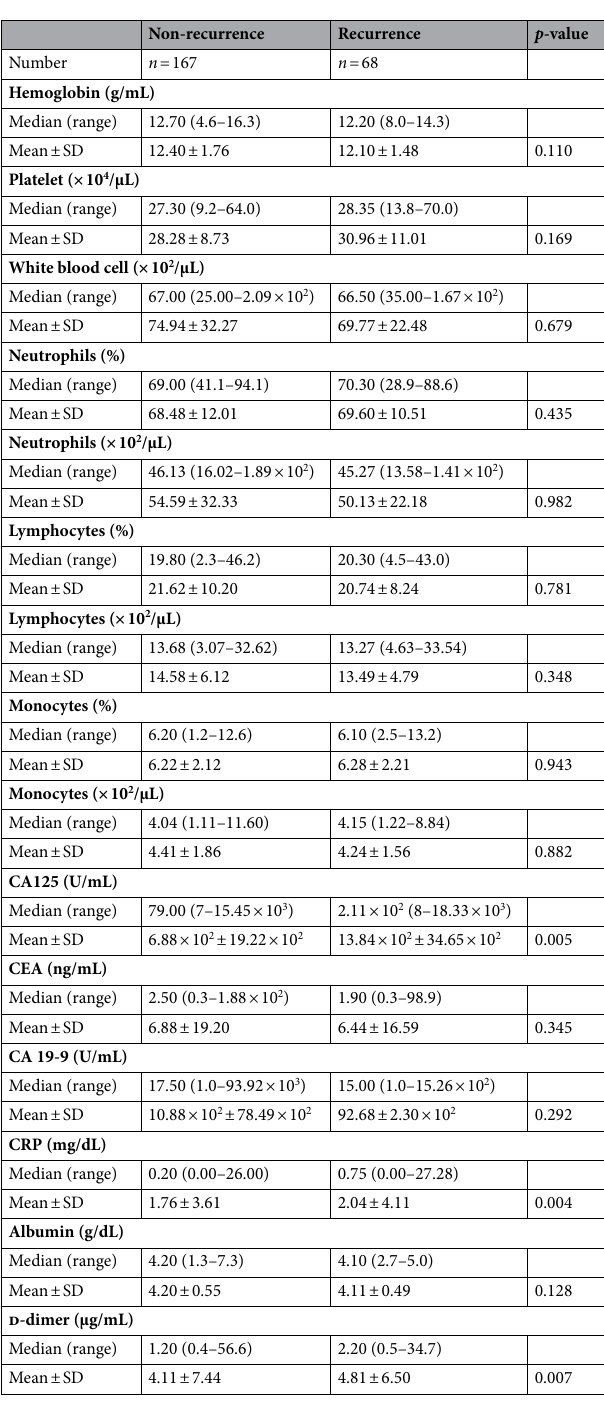
Table 2. Pre-treatment peripheral blood cell distributions. Hb hemoglobin, CA125 carbohydrate antigen125, CEA carcinoembryonic antigen, CA 19-9 carbohydrate antigen 19-9, CRP C-reactive